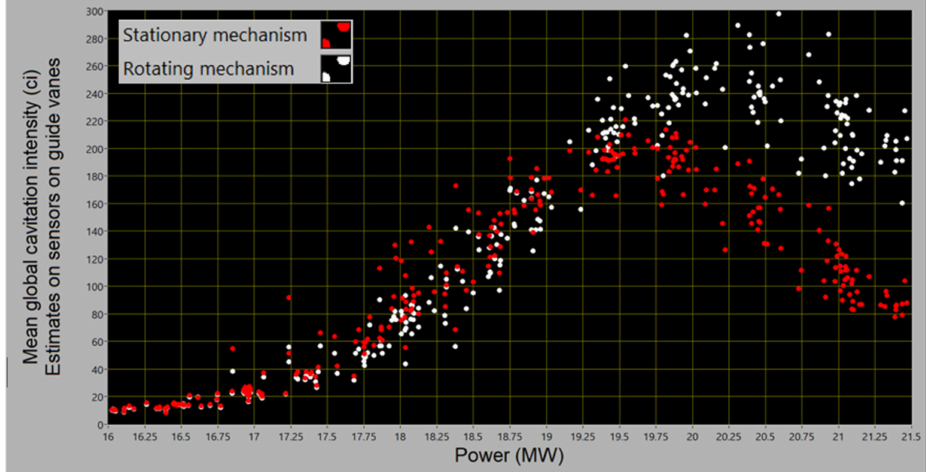
Fluids 2022 , 6 , x